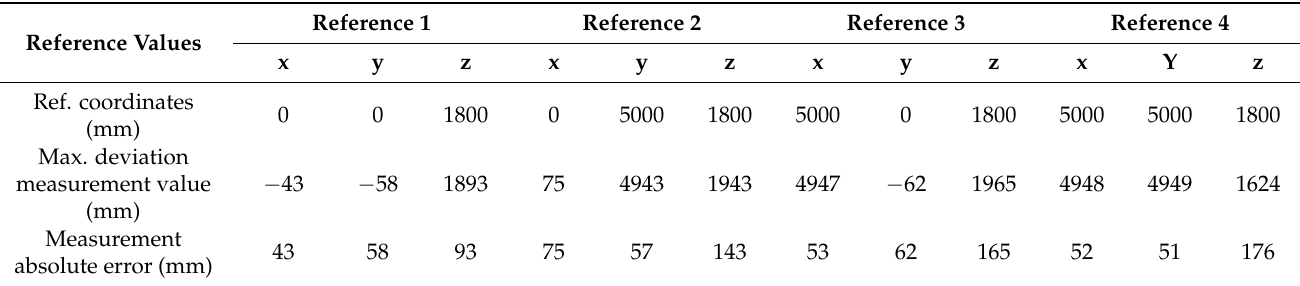
Table 2. Measurement error for an immovable